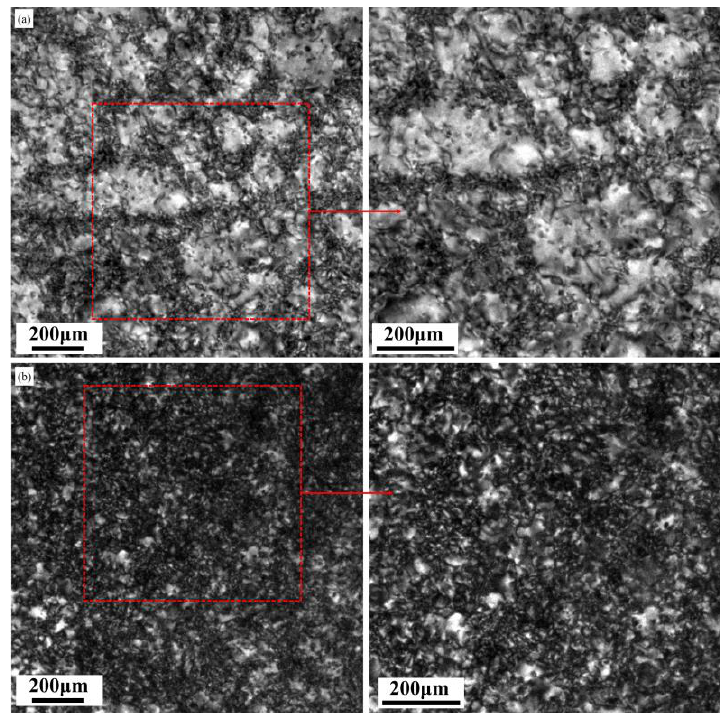
Figure 15. TEM bright-field photographs of the W-state 2195 alloys after a tensile strain of 0.12 at ( a ) 298 K, and ( b ) 77 K.